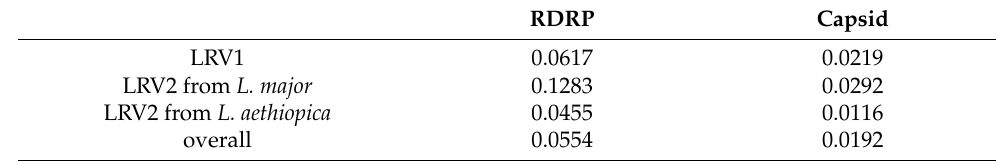
Table 2. Variation of dN/dS ratio in RDRP and capsid genes across the LRV tree. RDRP Capsid LRV1 0.0617 0.0219 LRV2 from L. major 0.1283 0.0292 LRV2 from L. aethiopica 0.0455 0.0116 overall 0.0554 0.0192